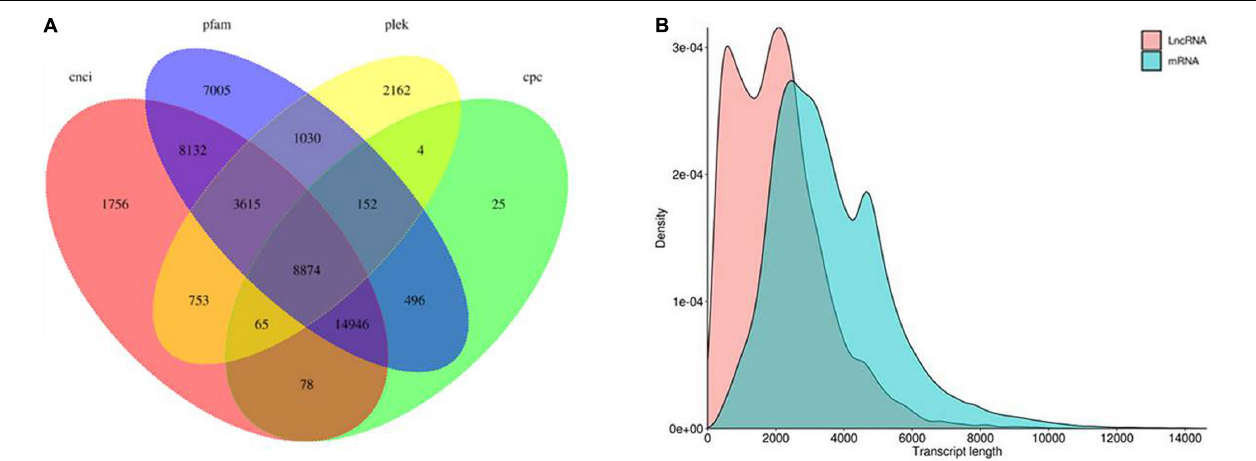
FIGURE 7 | Long non-coding RNA (lncRNA) prediction. (A) Venn diagram of the lncRNA prediction results by four software. (B) Length distribution of lncRNAs and mRNAs.